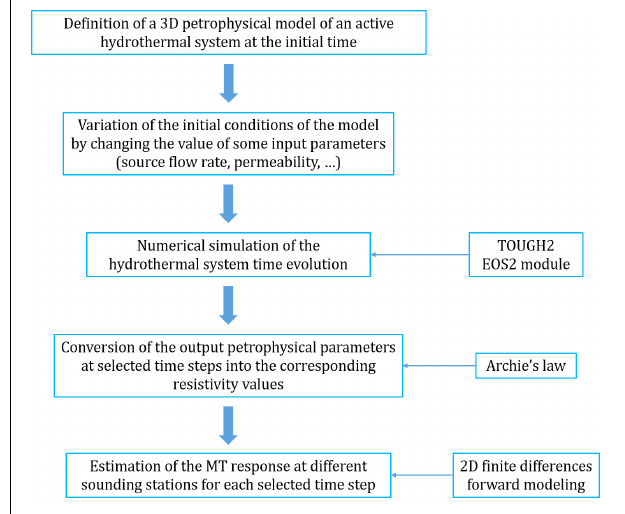
FIGURE 1 | Flow chart of the procedure proposed to study the MT sensitivity to hydrothermal system